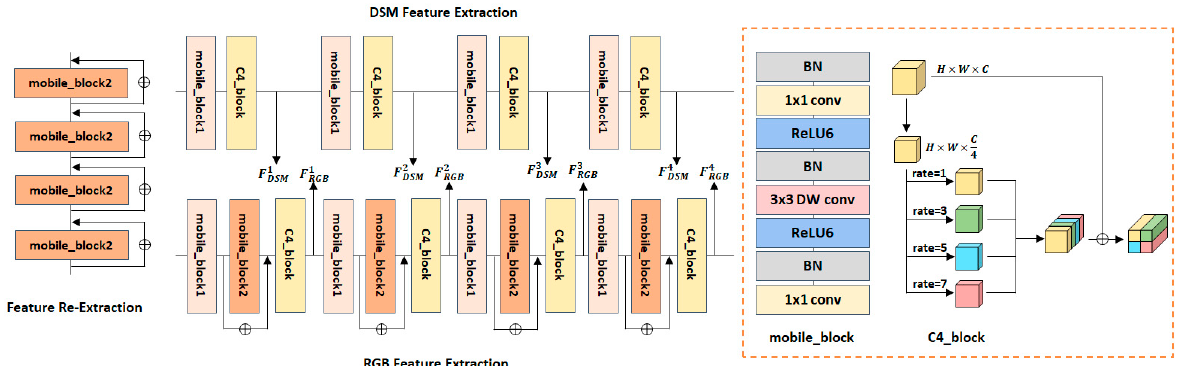
Figure 4. Schematic diagram of the feature extraction module.